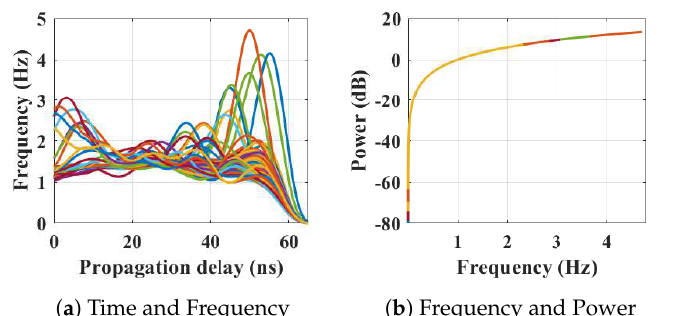
Figure 4. The relationship between propagation delay, activity frequency, and received power from the radar responses obtained while the person is present in the kitchen space has been considered as C1 in classification phase.